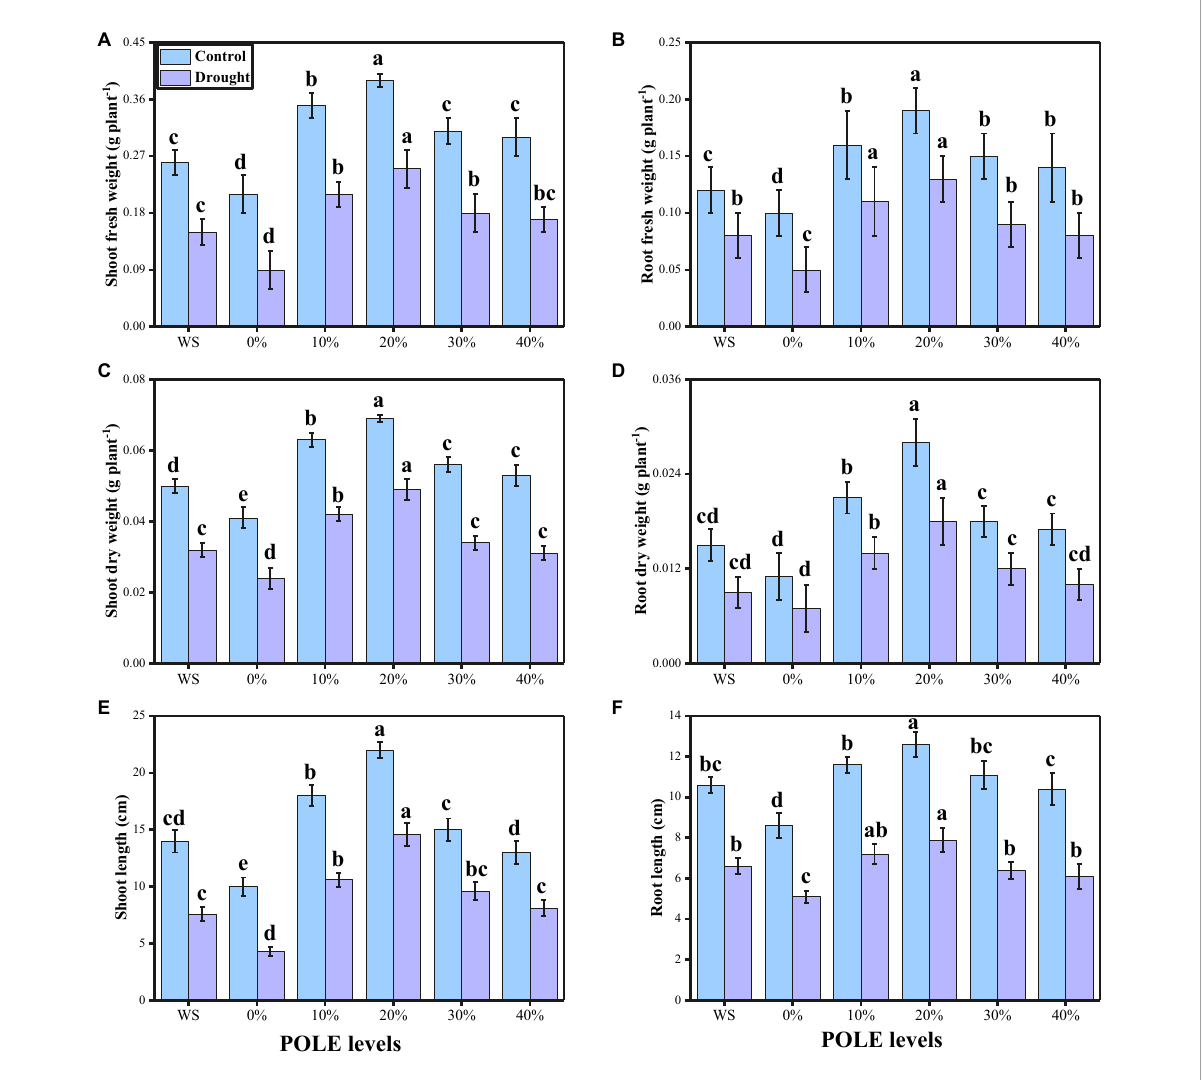
FIGURE2 Effect of seed priming with Plantago ovata Forsk leaf extract (POLE) on shoot fresh weight (A) , root fresh weight (B) , shoot dry weight (C) , root dry weight (D) , shoot length (E) , and root length (F) under well-watered and drought-stressed environment in wheat. Means sharing similar letter(s) within a column for each parameter do not differ significantly at P < 0.05. Data in the figures are means of four repeats ( n = 4) of just one harvest of wheat plants ± standard deviation (SD). Different lowercase letters on the error bars indicate significant difference between the treatments. Different treatments of POLE used in this study are as follows: WS (Control, without POLE + without water), 0% (0% POLE), 10% (10% POLE), 20% (20% POLE), 30% (30% POLE), and 40% (40%